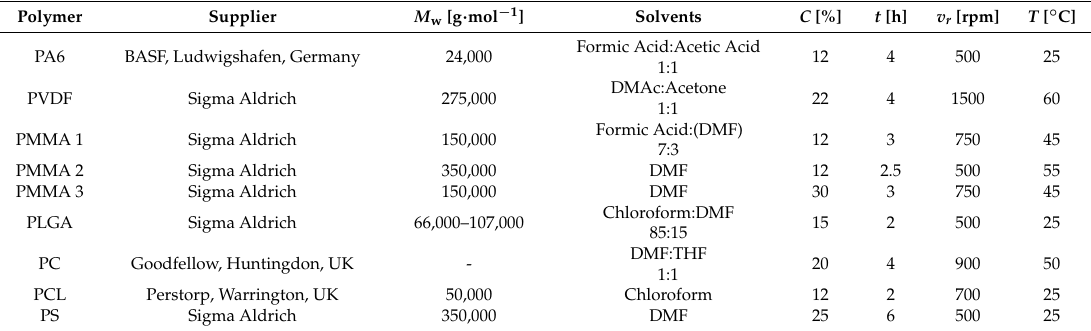
Table 1. Details of solution preparation for electrospinning and spin-coating for all polymers including molecular weight ( M w ), concentration w / w (C), solvents, stirring time ( t ), the rotation speed of stirrer ( v r ), and temperature of the hot plate during mixing.